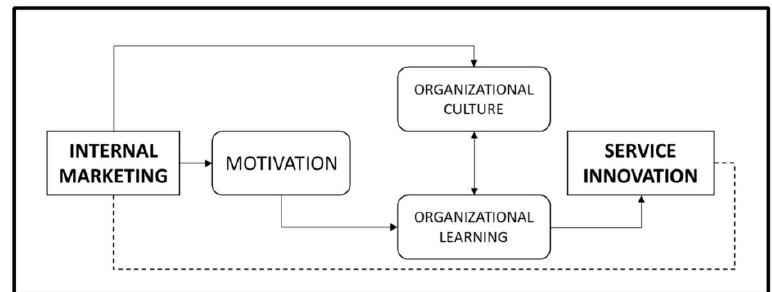
Figure 5. The link between internal marketing and service innovation. Source: Figure developed by the authors using findings in the systematic review.